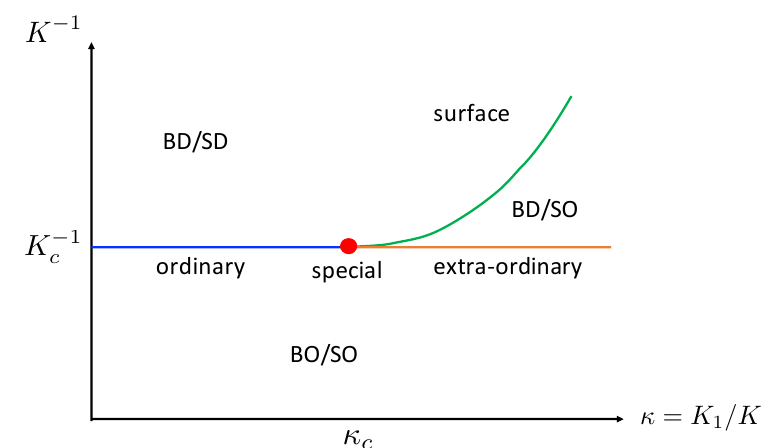
Figure 1: Conventionally accepted phase diagram of the classical O ( N ) model with a boundary in dimension d > 3. BO stands for bulk ordered, SO - surface ordered, BD - bulk disordered, SD - surface disordered. For d = 3 and N = 1 the phase diagram is the same. For d = 3 and N = 2 the phase diagram has the same topology, but the BD / SO region only has quasi-long-range surface